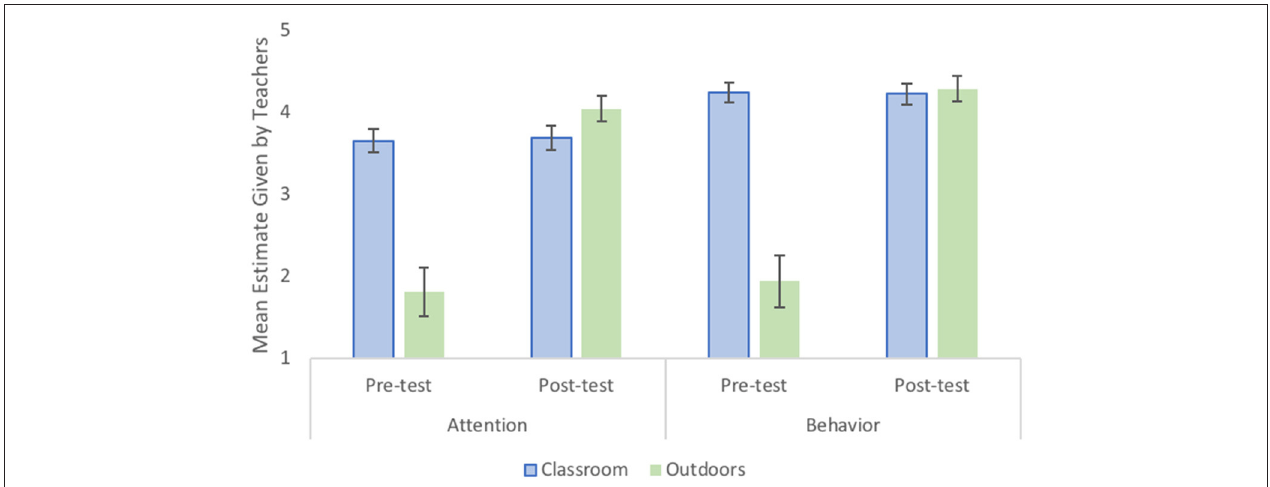
FIGURE 1 | Classroom and outdoor attention behavior among the treatment group. Teachers provided estimates of attention span and behavior levels from short (1) to long (5) and poor (1) to excellent (5), respectively. Error bars represent standard error. Paired t -tests indicate that differences between the teacher-reported pre- and post-test scores for attention and behavior while outdoors were significant (attention: t = − 5.70, p = 0.000; behavior: t = − 5.50, p = 0.000) as well as differences between the post-test scores in the classroom vs. outdoor settings (attention: t = − 5.23, p = 0.000; behavior: t = – 295, p = 0.003).